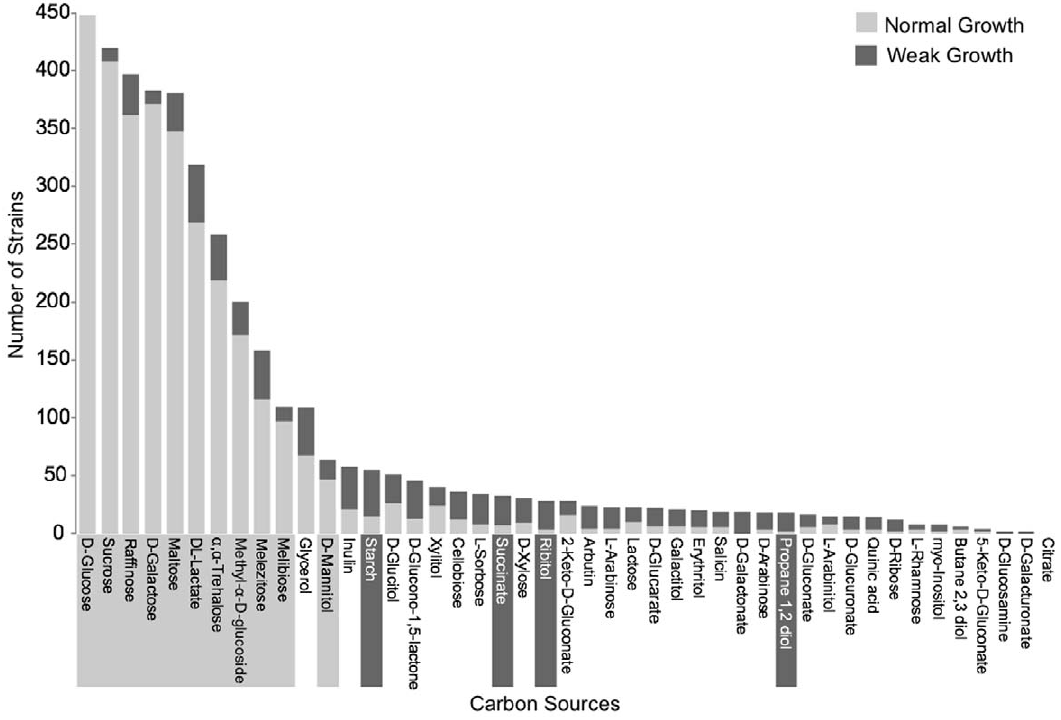
Figure 2. Strains show a bias for weak or normal growth phenotypes for 15 carbon sources. The light and dark grey bars represent weak and normal growth phenotypes, respectively. The light and dark grey boxes surrounding the carbon source names represent carbon sources which display an overrepresentation for a normal or weak growth phenotype, respectively, across all strains ( x 2 -test; p , 0.001). doi:10.1371/journal.pone.0054403.g002 PLOS ONE |